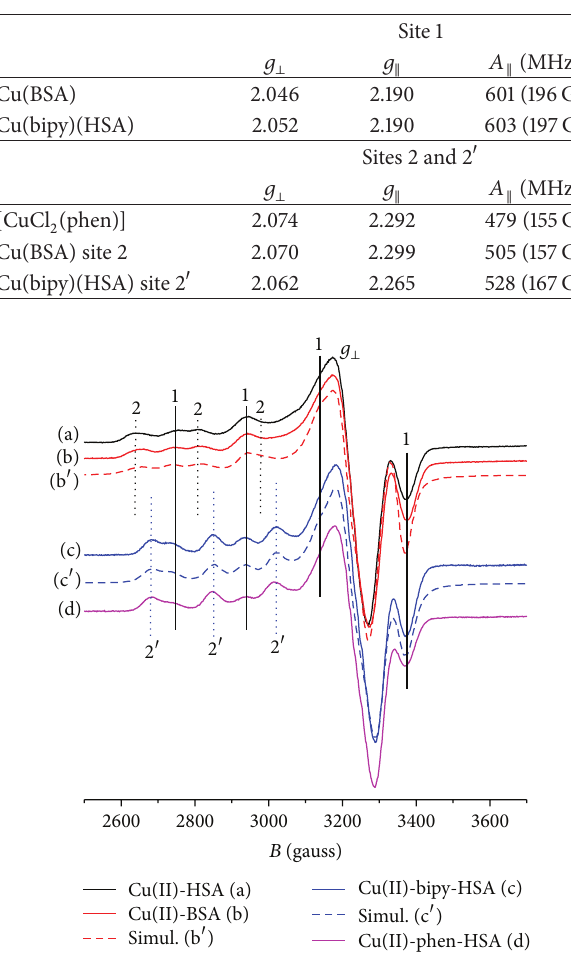
Table 4: EPR parameters obtained from simulated Cu(II) com- plexes interaction with HSA and BSA.